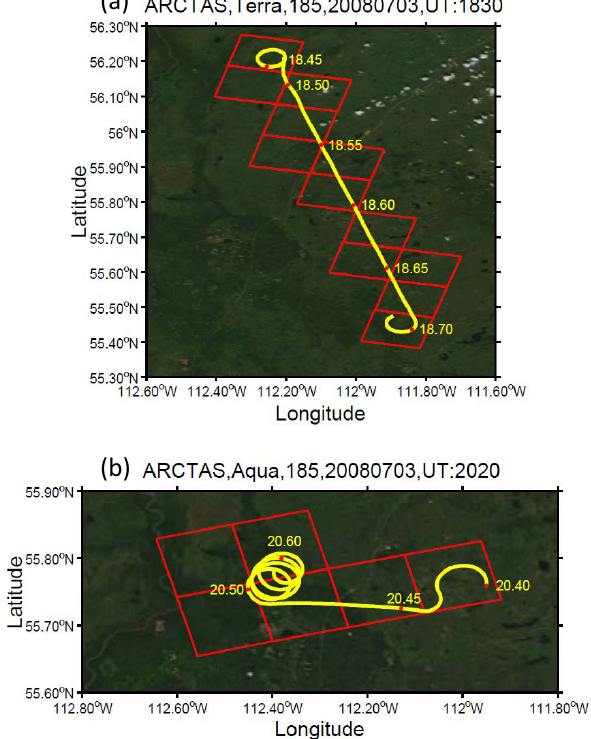
Figure 8. Overlays of MODIS RGB image with 10-km retrieval grid cell and P-3 flight track Fig. 8. Overlays of MODIS RGB image with 10km retrieval grid locations for (a) Terra overpass at 18.5 UT and (b) Aqua overpass at 20.3 UT on 03 July 2008. cell and P-3 flight track locations for (a) Terra overpass at 18.5UT and (b) Aqua overpass at 20.3UT on 3 July